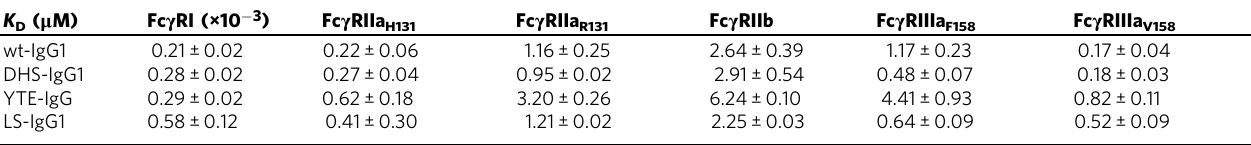
Table 4 K D values for human Fc γ Rs determined by SPR